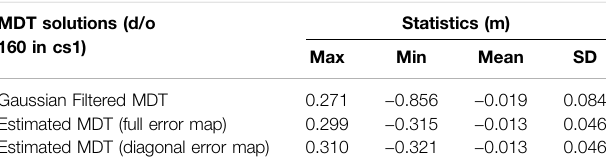
TABLE 3 | Statistics of mis fi ts between MDTs using ITSG against the Synthetic_MDT. MDT solutions (d/o 160 in